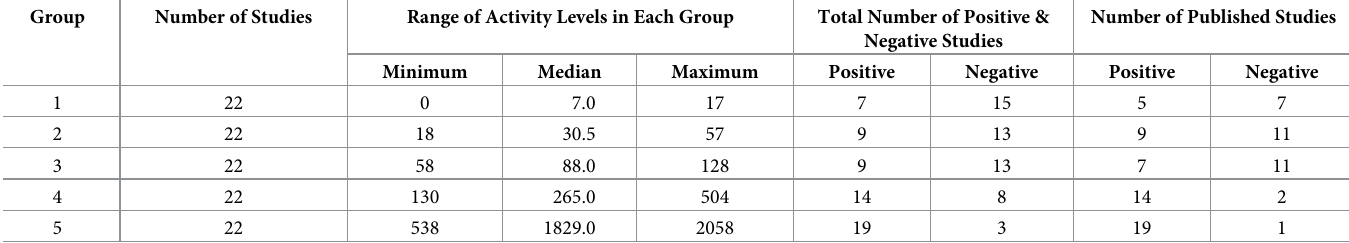
Negative results were more frequent at lower activity levels where citation numbers were lower, and positive results were more frequent at higher activity levels where citation num- bers were much higher (Fig 6B). In addition, publications reporting positive, statistically sig- nificant results were cited much more often than publications reporting negative results: 63.26 ± 7.74 citations for positive studies (mean ± SEM), and only 21.6 ± 4.02 citations for negative studies. A between-groups ANOVA showed statistically significant differences in 2-year citation numbers from publications reporting positive results compared to publica- tions reporting negatives results, F (1, 84) = 13.98, p < 0.0003 (Fig 6B). Differences between positive and negative publications were still just as clearly evident even if raw citation num- bers were normalized for year of publication and field of study using the RCR, F (1,84) = 17.53, p < 0.0001 (Fig 6B).